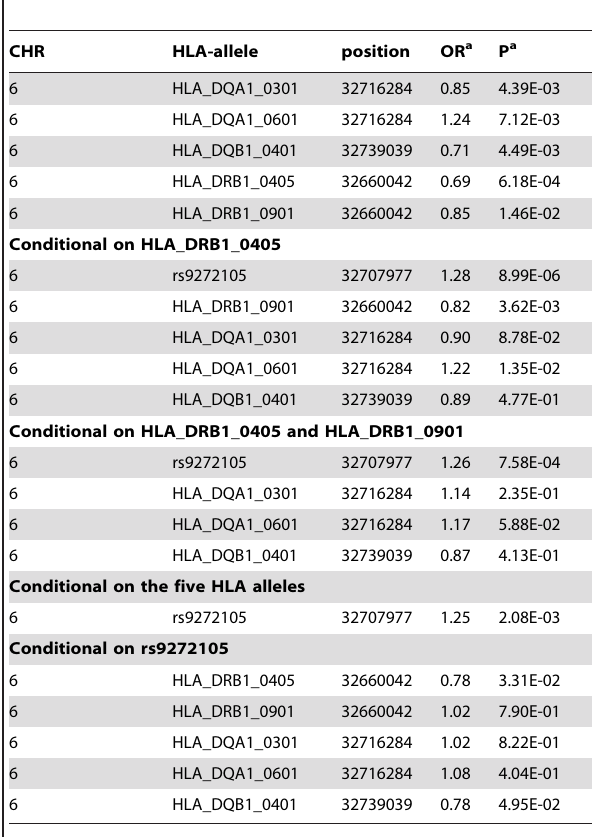
Table 2. Summary of the association results of five imputed HLA alleles in the GWAS discovery